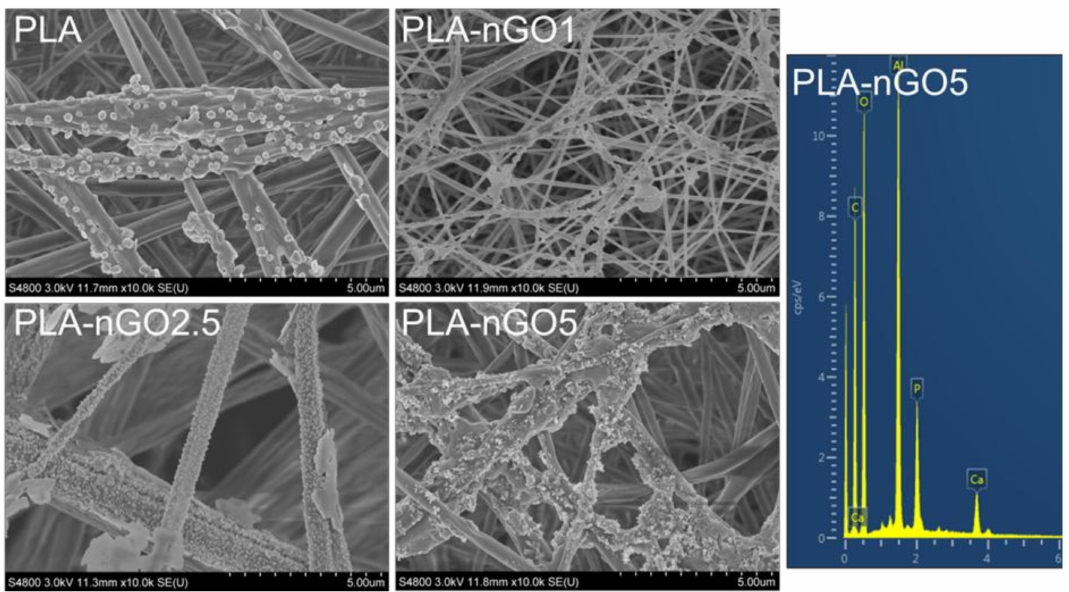
Figure 6. SEM images of PLA, PLA-nGO1, PLA-nGO2.5, and PLA-nGO5 fibers after 11 days of mineralization in simulated body fluid (SBF) and EDS spectra of PLA-nGO5 fibers after 11 days of mineralization in SBF.